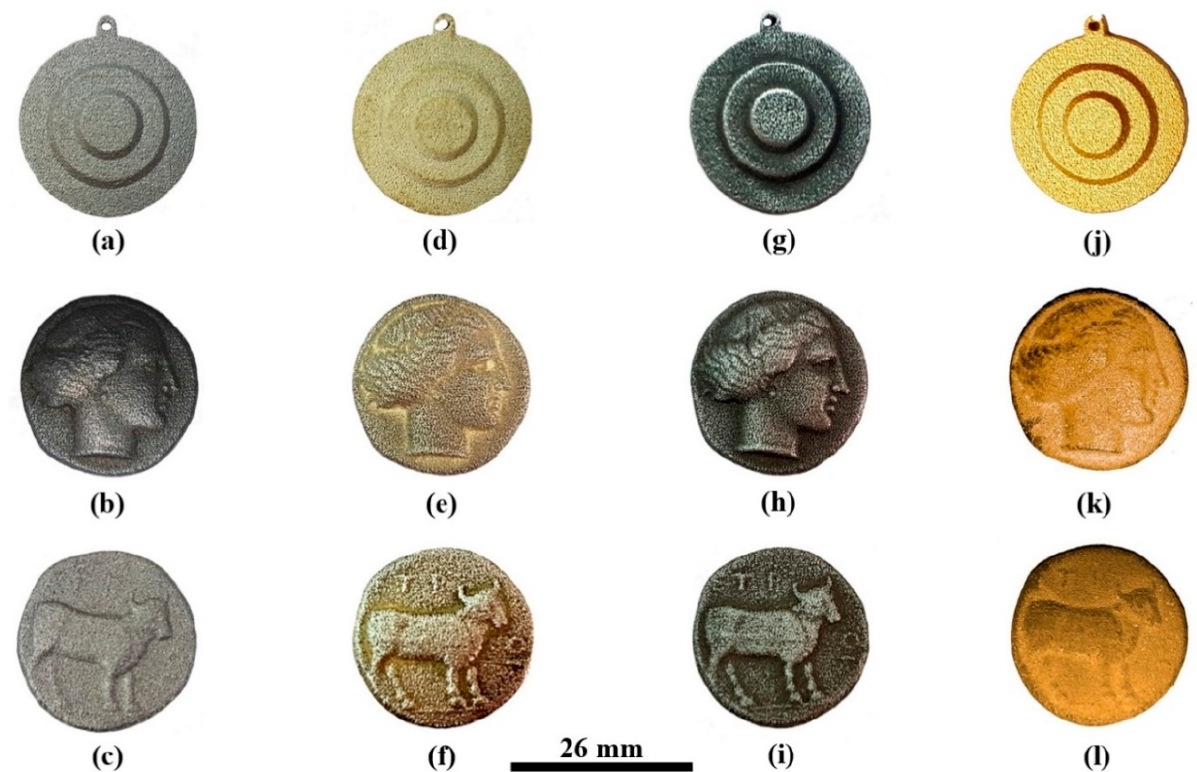
Figure 4. The experimental specimens before and after coating: ( a ) the as-printed AM-LPBF AlSi10Mg disk-shaped reference; ( b , c ) the as-printed AM-LPBF AlSi10Mg coin replica (obverse and reverse, respectively); ( d ) the as-printed disk-shaped specimen coated with Ag; ( e , f ) the coin replica coated with Ag; ( g ) the disk specimen coated with Ag after darkening process; ( h , i ) the coin replica coated with Ag after darkening process; ( j ) the disk-shaped specimen coated with Au; and ( k , l ) the coin replica coated with Au.